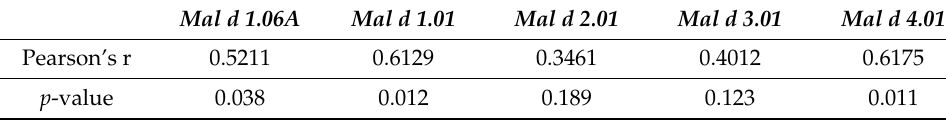
Table 3. Correlation between the mean expression and fruit maturity. Mal d 1.06A